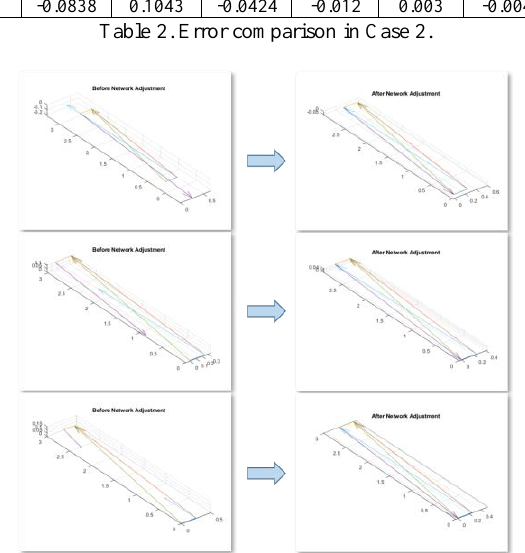
Figure 11. The differences of ROPs before and after applying network adjustment in Case 2.